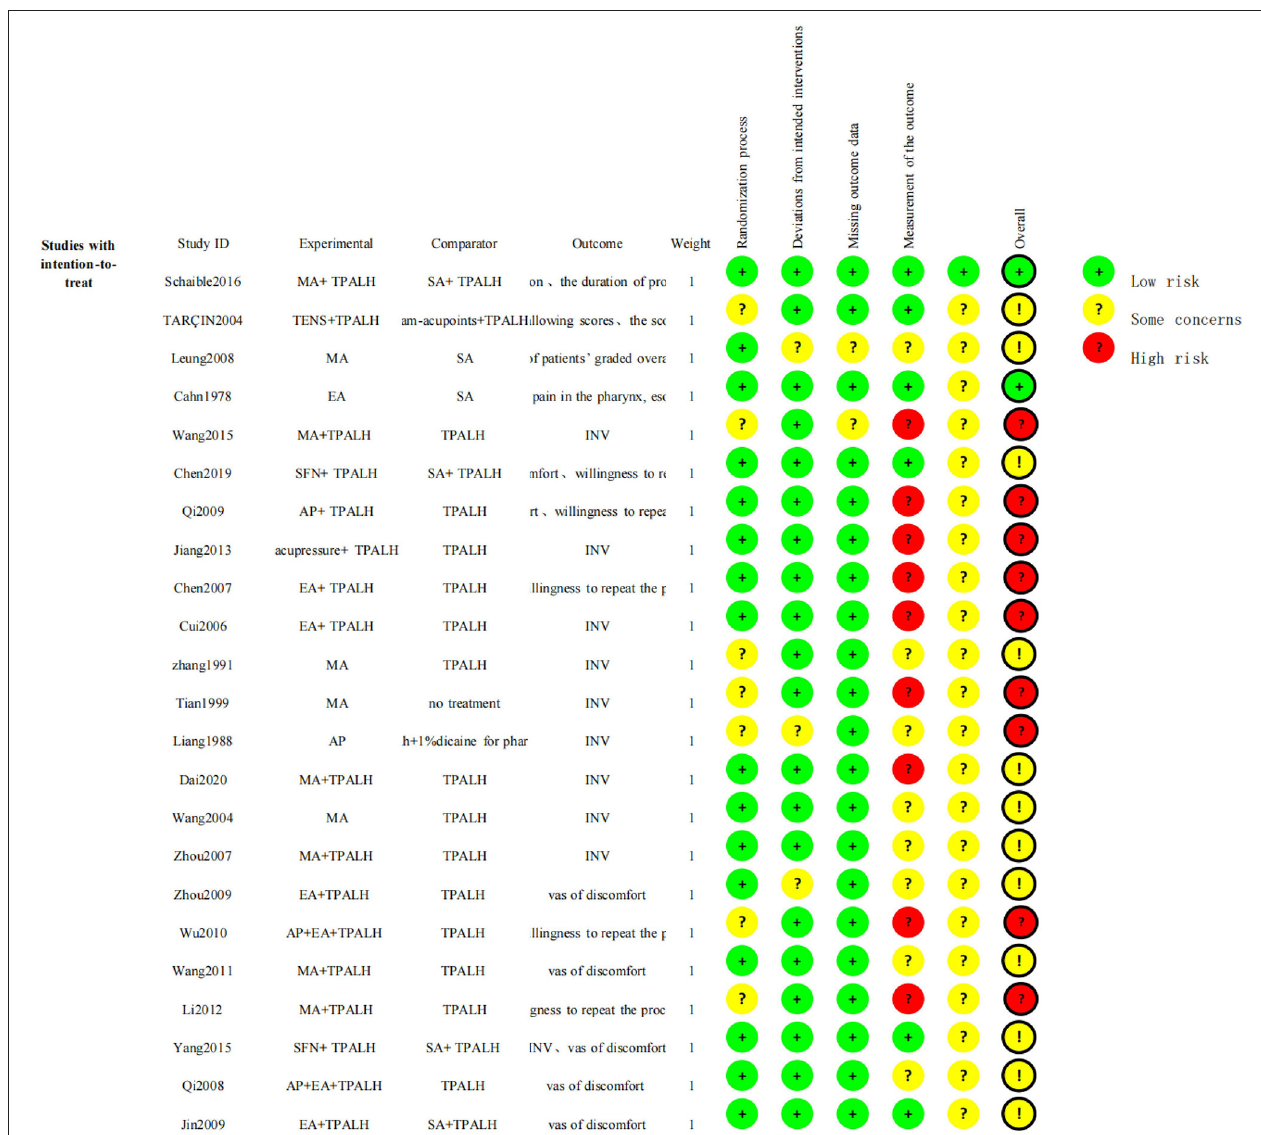
FIGURE 3 | Methodological quality graph: review authors’ judgements regarding each methodological quality item.